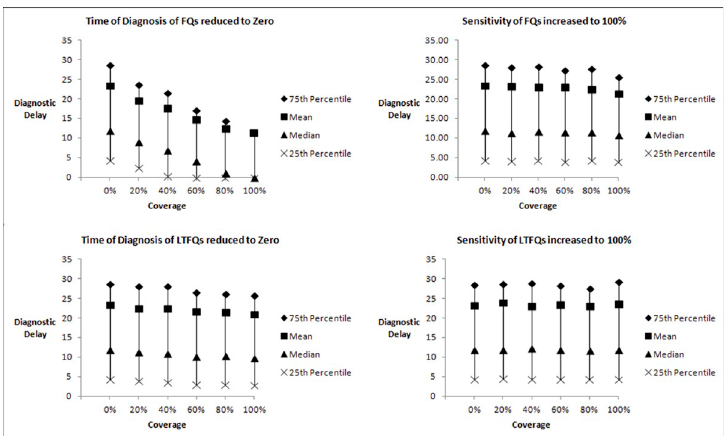
Fig 3. Effect of reduced time to diagnosis and increased diagnostic accuracy: Patna. Distribution of 10,000 simulations where time to diagnosis was minimized, and diagnostic accuracy (sensitivity) was maximized, for less- than-fully-qualified providers (LTFQs) and fully qualified providers (FQs). Coverage is the proportion of providers for whom the parameter specified was manipulated.